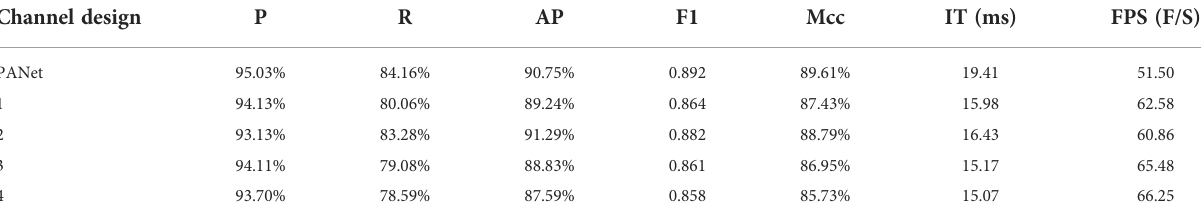
TABLE 4 Effectiveness test of neck feature fusion.